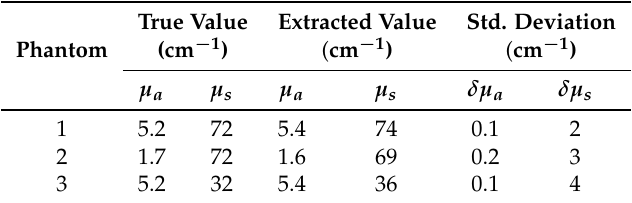
Table 3. Simultaneous reconstruction of absorption and scattering coefficients of the top layer from simulated data with prior knowledge of both the optical properties of bottom